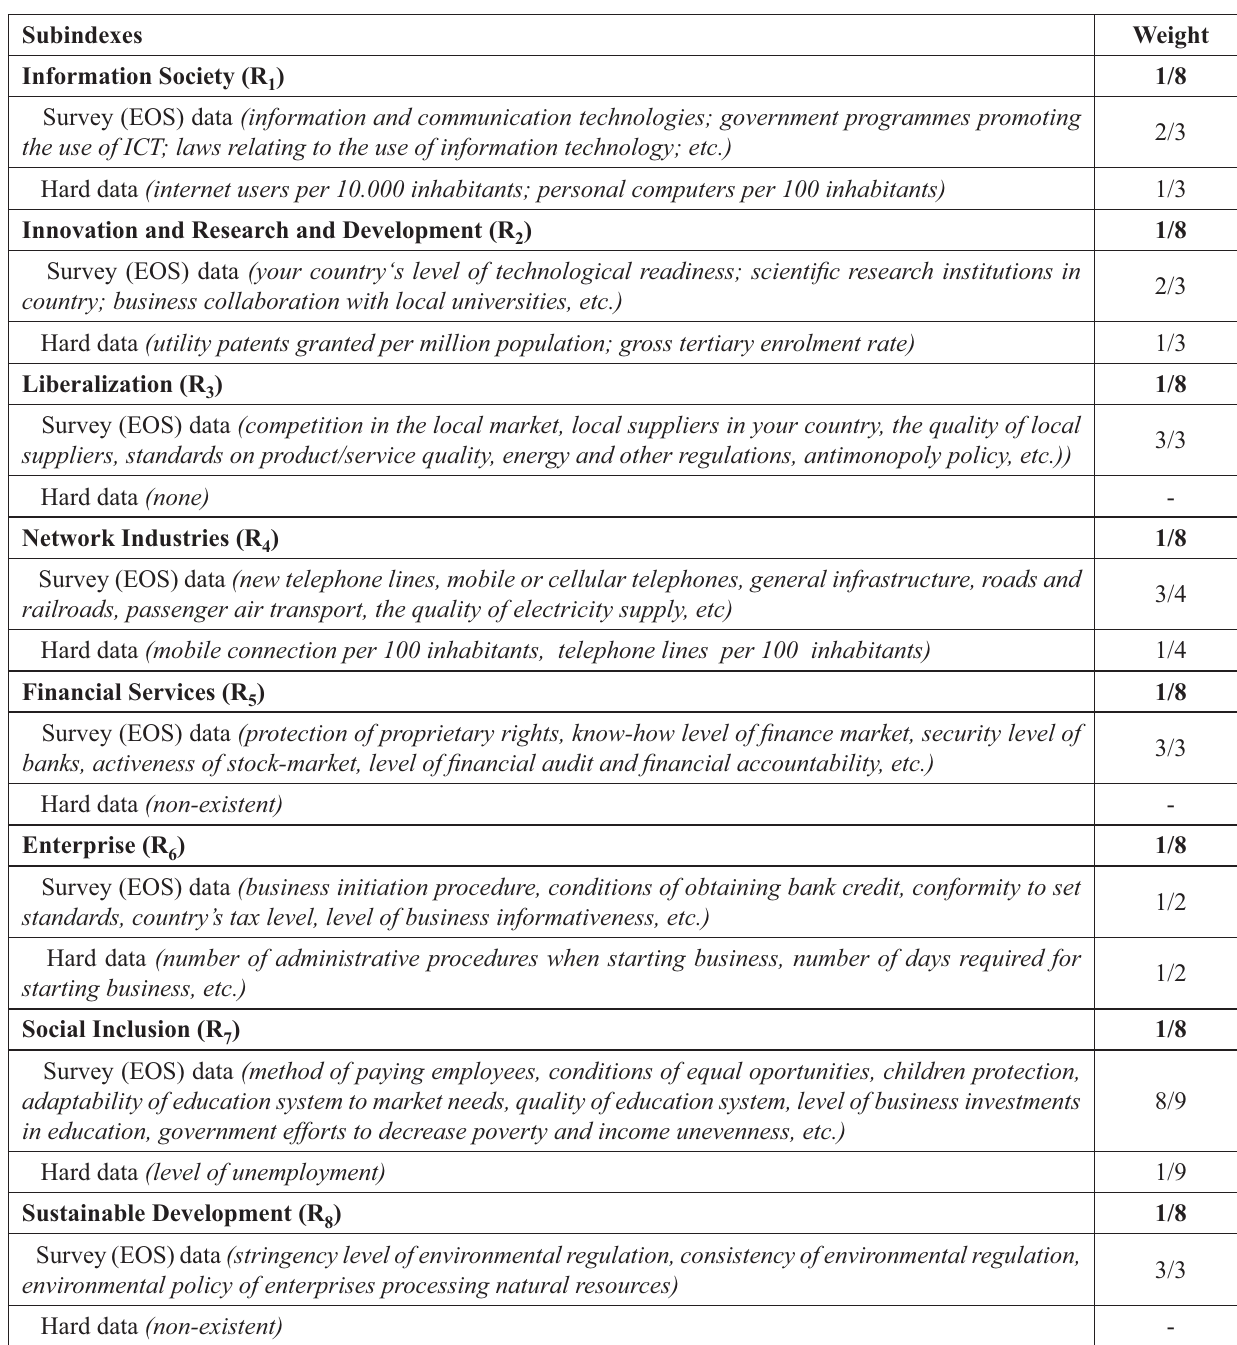
Table 1 . Groups of progress subindexes used in research and their